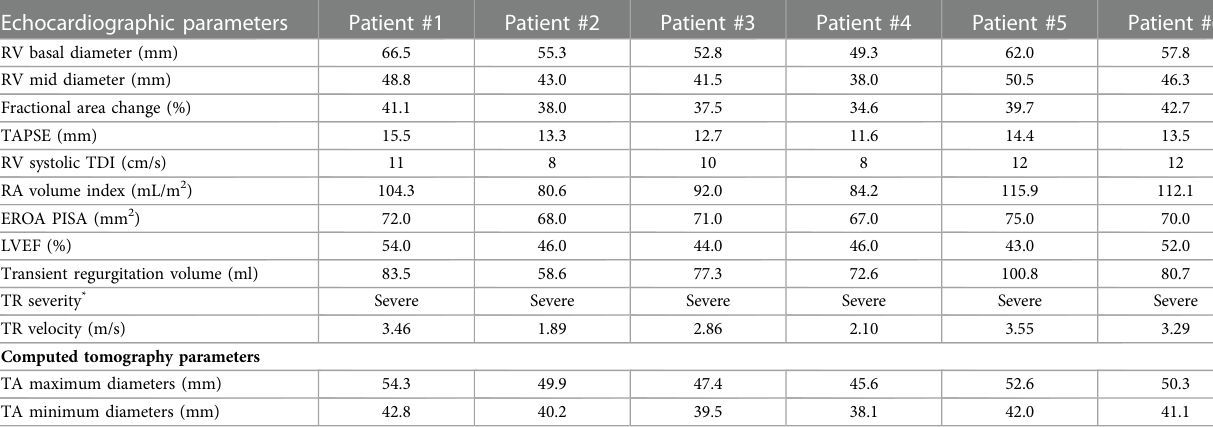
TABLE 3 Baseline echocardiographic and computed tomography